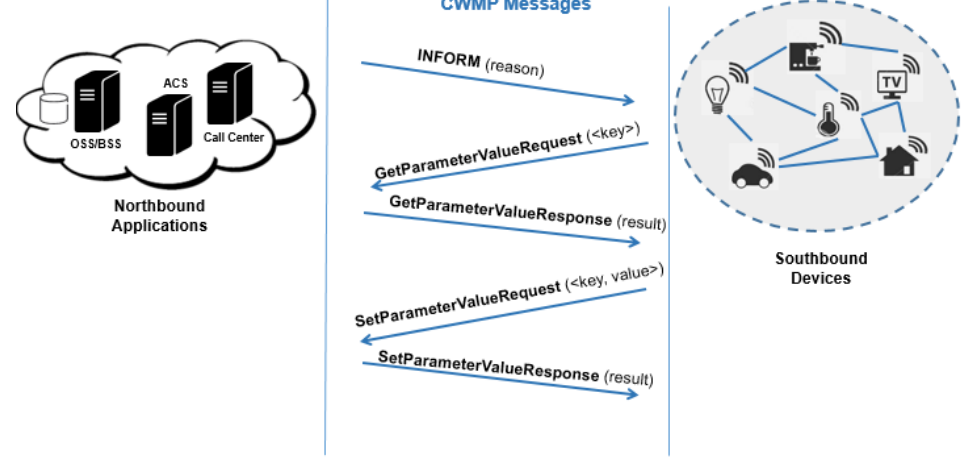
Figure 20. Illustration of the CWMP Protocol